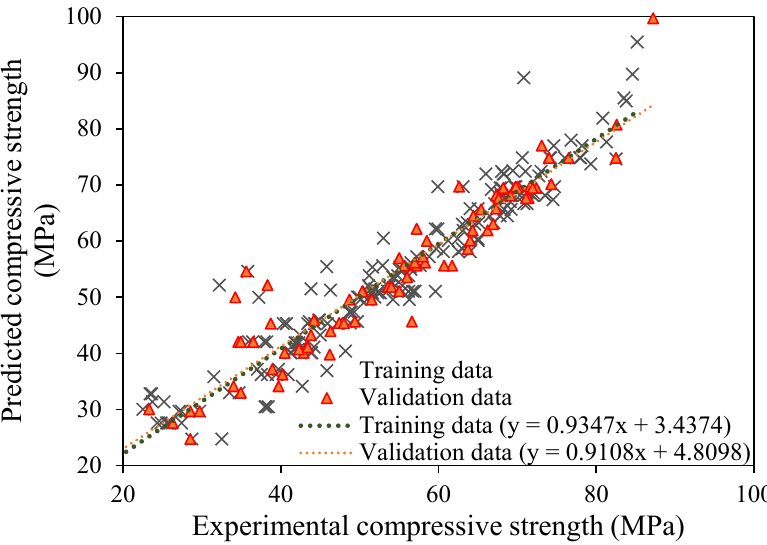
Figure 6. Comparison of regression slope for trial No. 5.